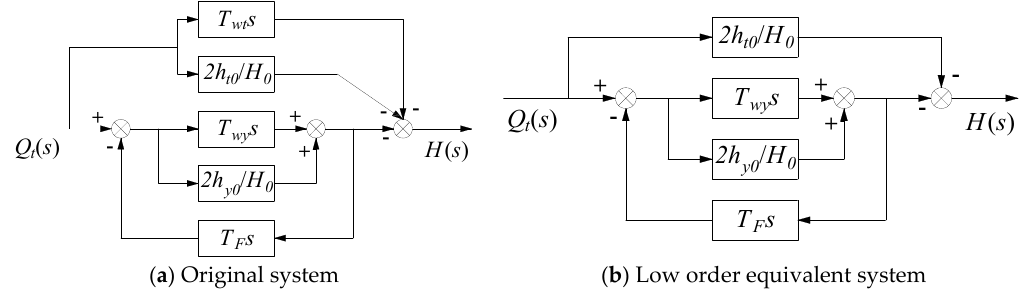
Figure 14. Structure diagram of the pipeline system [68].